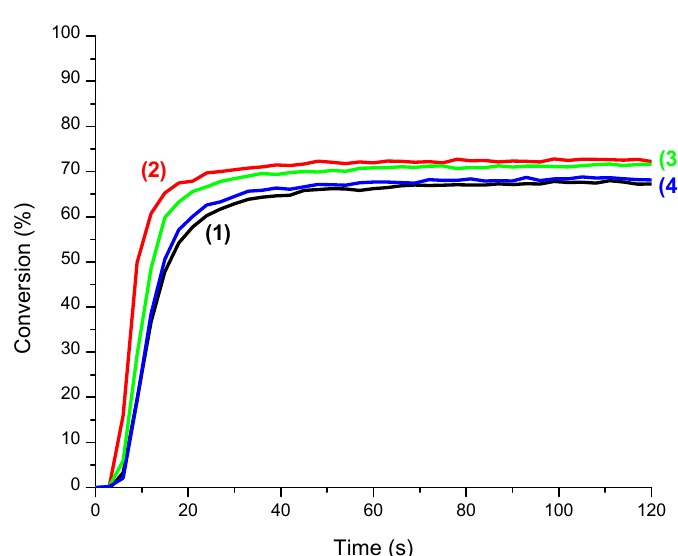
Figure 4. Photopolymerization profiles (methacrylate function conversion vs. irradiation time) for a Spectrum ® TPH ® 3 resin blend (under air; 1.4 mm thick films) upon exposure to the LED@455 nm (I 0 = 80 mW · cm − 2 ) using di ff erent photoinitiating systems. (1) CQ / EDB (0.2 / 0.5 % w / w ); (2) CQ / EDB / SC938 (0.2 / 0.5 / 1 % w / w ); (3) CQ / EDB / S5 (0.2 / 0.5 / 1 % w / w ); (4) CQ / EDB / S6 (0.2 / 0.5 / 1 % w / w ). The irradiation starts for t = 5s.